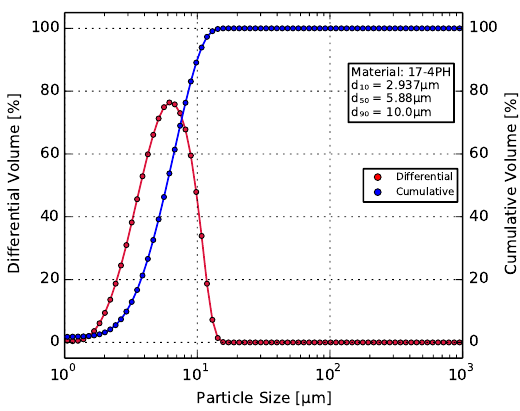
Figure 2. Particle size distribution of the steel micropowder, with a d 50 value of 5.88µm.